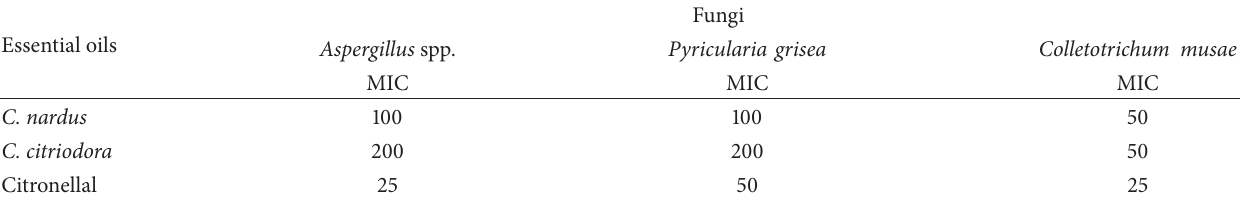
Table 3: Percent of inhibition (%) of essential oils and the major constituent citronellal (0.47 mg ⋅ mL −1 ) in PDA in the micelia devel- opment of P. grisea , Aspergillus spp . , and C. musae , after 14 days. Fungi Essential oils Aspergillus spp.